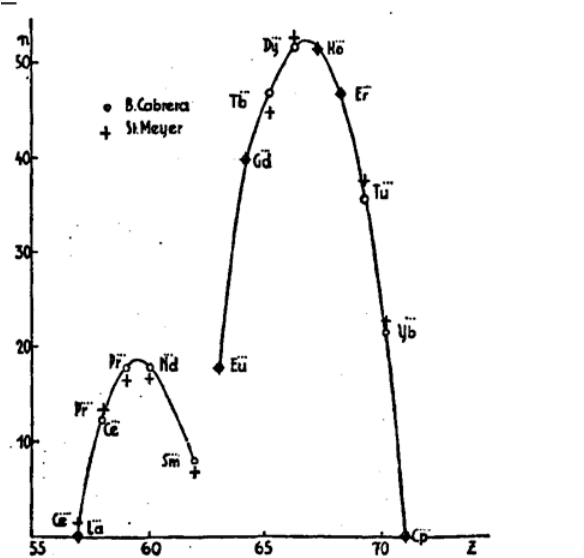
Fig. 7 The magnetization numbers (Weiss’s magnetons) of the rare earth elements (lanthanum 57 La to cassiopeium 71 Cp). n: Weiss’s magnetons; Z = atomic number (= number of protons). Source 50 : Stefan Meyer, Magnetization numbers of the rare earths, Physikalis- cheZeitschrift , 1925 , 26, p.